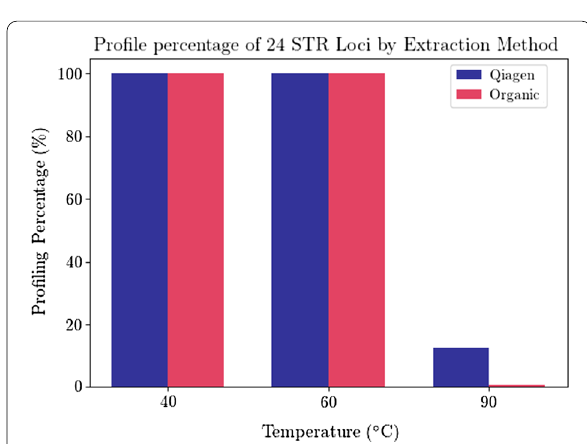
Fig. 13 Profile percentage of STR loci for two methods. The percentage is based on the number of STR locus out of